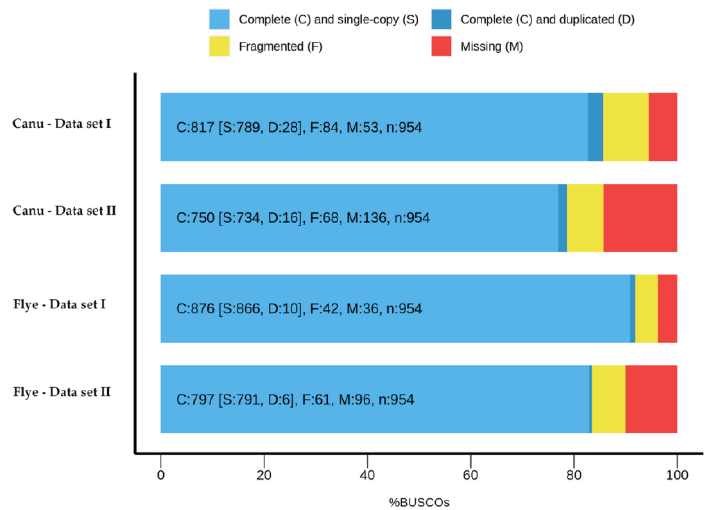
Figure 2. BUSCO assessment of the four de novo genome assemblies. Bar charts show gene pro- portions classified as: complete (C) as single-copy (S, light blue) or duplicated (D, dark blue); fragmented (F, yellow) and missing (M, red). Inside the light blue bars the number of genes falling into each category (BUSCO scores) is displayed.